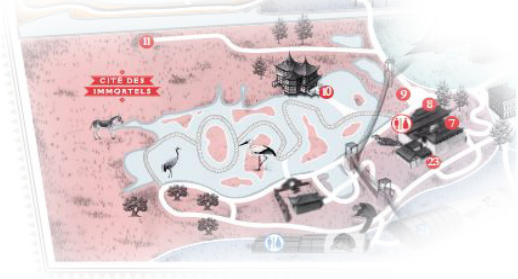
Figure 2. Site plan of the Chinese garden in Pairi Daiza (Image source: